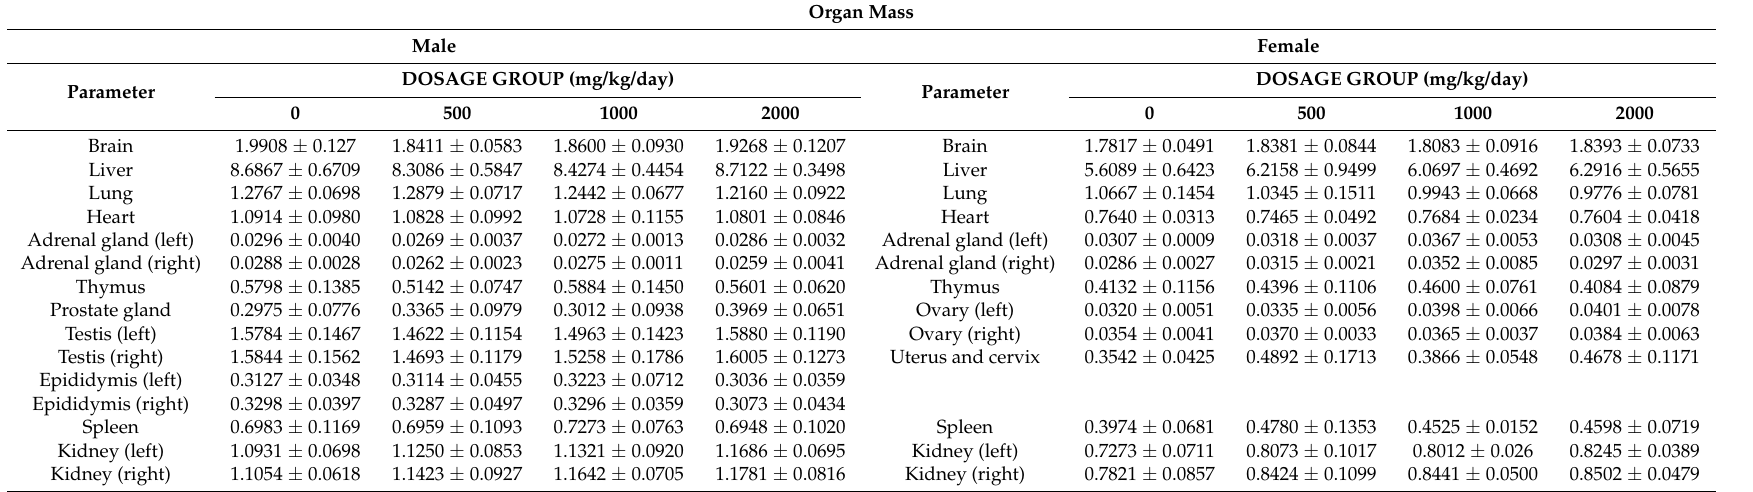
Table 4. Organ masses (g) of male and female rats given 500, 1000, or 2000 mg/kg/day GEE for 14 days in a repeated oral dose toxicity